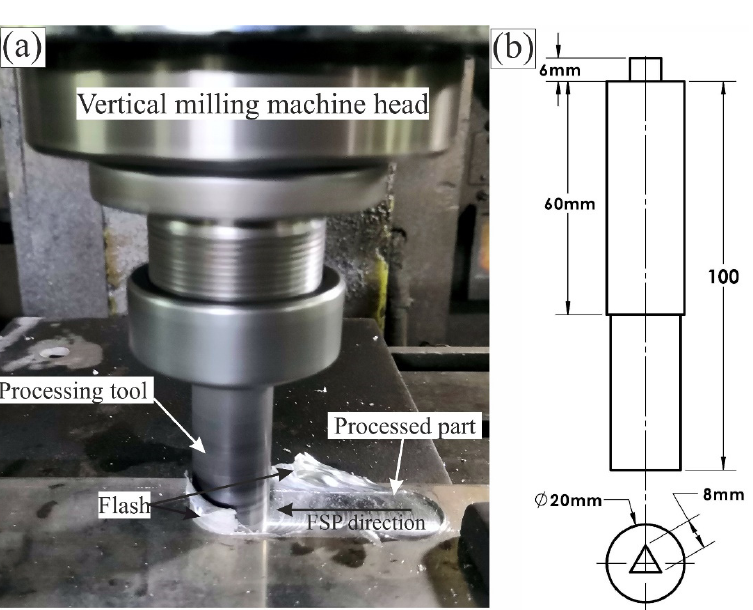
Figure 1. ( a ) The setup of the experimental friction stir processing and ( b ) the design of the used FSP tool.